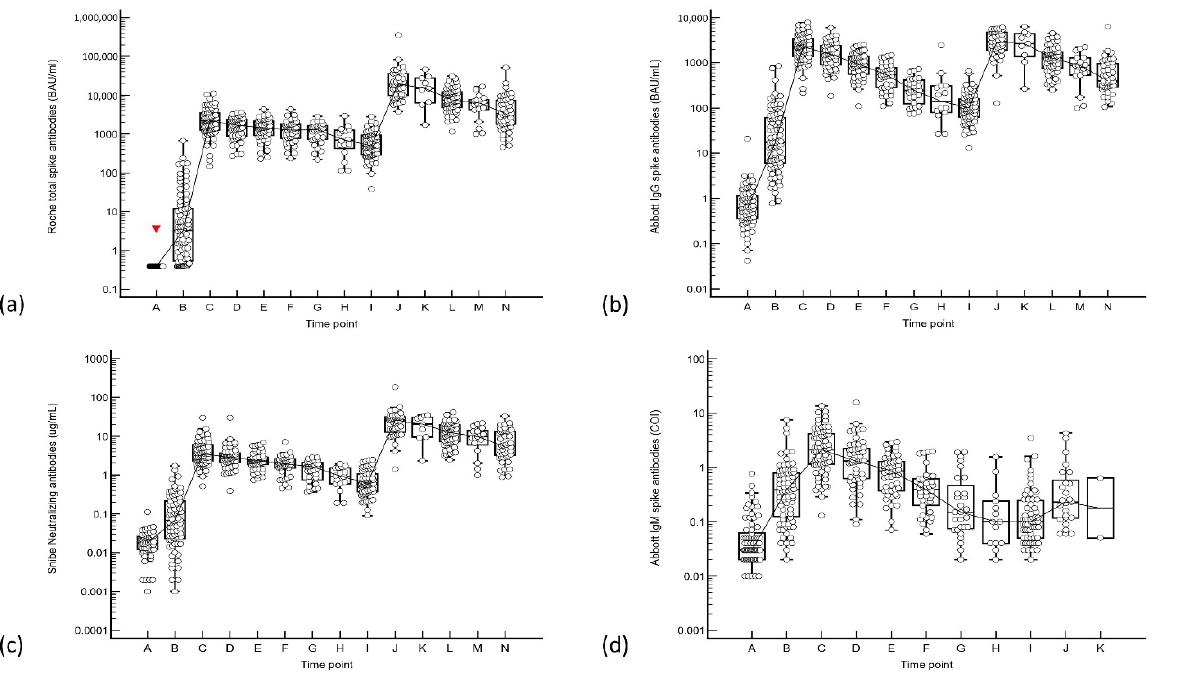
Figure 1. ( a ) Roche total spike antibody, ( b ) Abbott IgG, ( c ) Snibe neutralizing antibody and ( d ) Figure 1: a) Roche total spike antibody, b) Abbott IgG, c) Snibe neutralizing antibody and d) Abbott IgM responses to 3 doses of Pfizer mRNA vaccine.